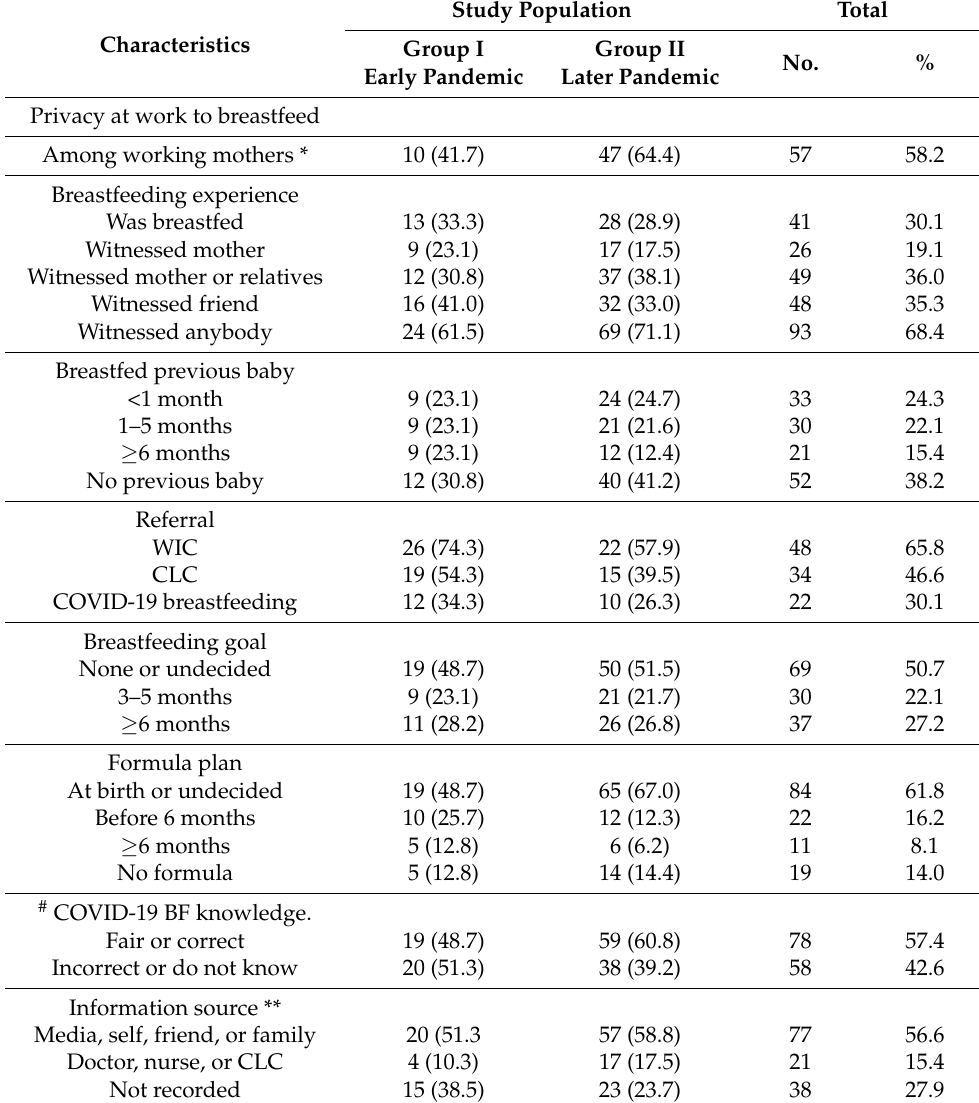
Table 2. Preparation for safe breastfeeding among participating mothers during the early and later COVID-19 pandemic periods.